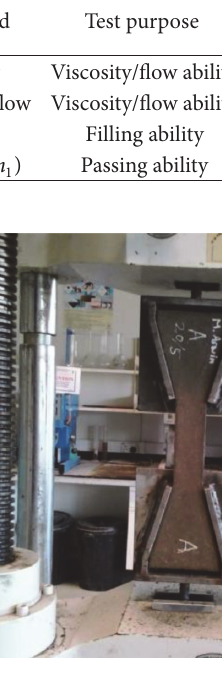
Figure 3: Direct tensile test for